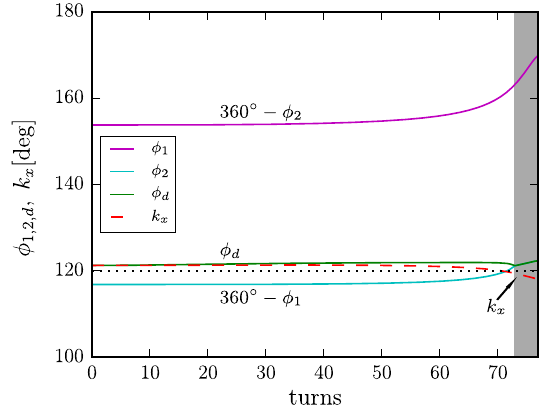
FIG. 16. Phase shifts of the envelope modes ϕ 1 , ϕ 2 and dispersion mode ϕ numerically solved from the coupled FIG. 14. Space-charge depressed phase advances k (solid d x;y envelope approach during bunch compression with k 0 lines) obtained from the coupled envelope approach and emit- 104 °. (Shaded area denotes the stop band of the tance growth ϵ (dashed lines) from PIC simulations during and k 0 dx;dy ;y ¼ 122 ° and k 104 °. bunch compression with k 0 dispersion-induced 0 ;y ¼ ;x ¼